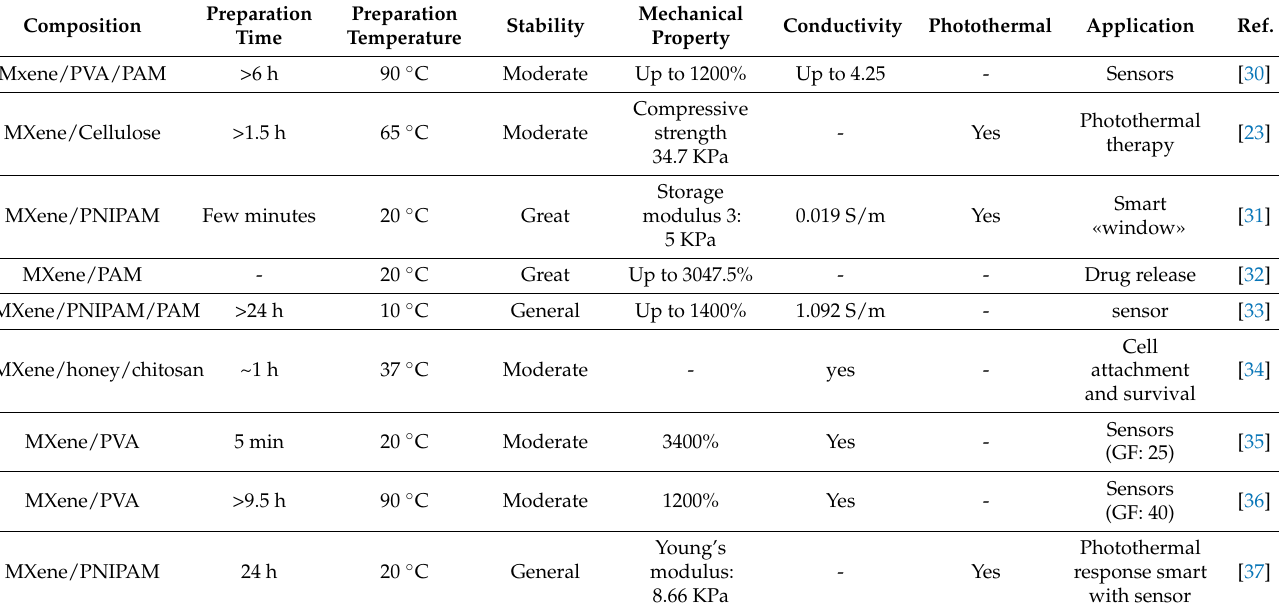
Table 2. An overview of MXene hydrogel